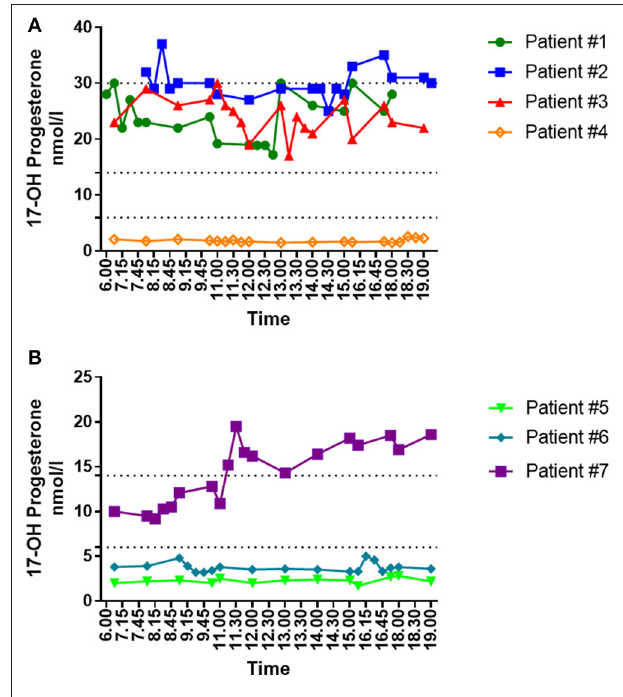
FIGURE 4 | Individual daytime variation in mid-luteal serum 17-OH P 4 levels in women undergoing IVF treatment and fresh embryo transfer. (A) Daytime variations in mid-luteal serum 17-OH P 4 in four women treated in the long GnRH agonist protocol and trigged for final oocyte maturation with hCG. All patients received vaginal P 4 for luteal phase support. Dotted lines depict 6, 14, and 30 nmol/l, respectively. (B) Daytime variations in mid-luteal serum 17-OH P 4 in three women treated in the GnRH antagonist protocol and trigged for final oocyte maturation with a bolus of GnRH agonist. All patents received vaginal P 4 for luteal phase support in combination with one (patient#5 and #6) or two (patient #7) boluses of hCG on the day of oocyte pick-up and 5 days later, respectively. Dotted lines depict 6 and 14